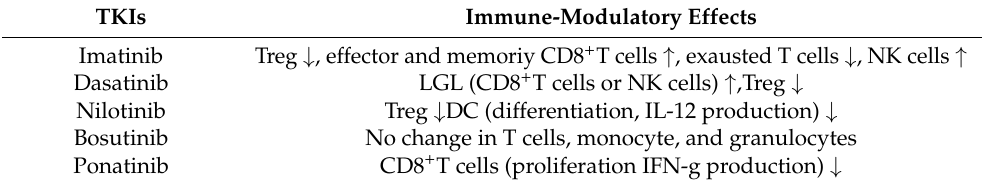
Table 1. Immune-modulatory effects of